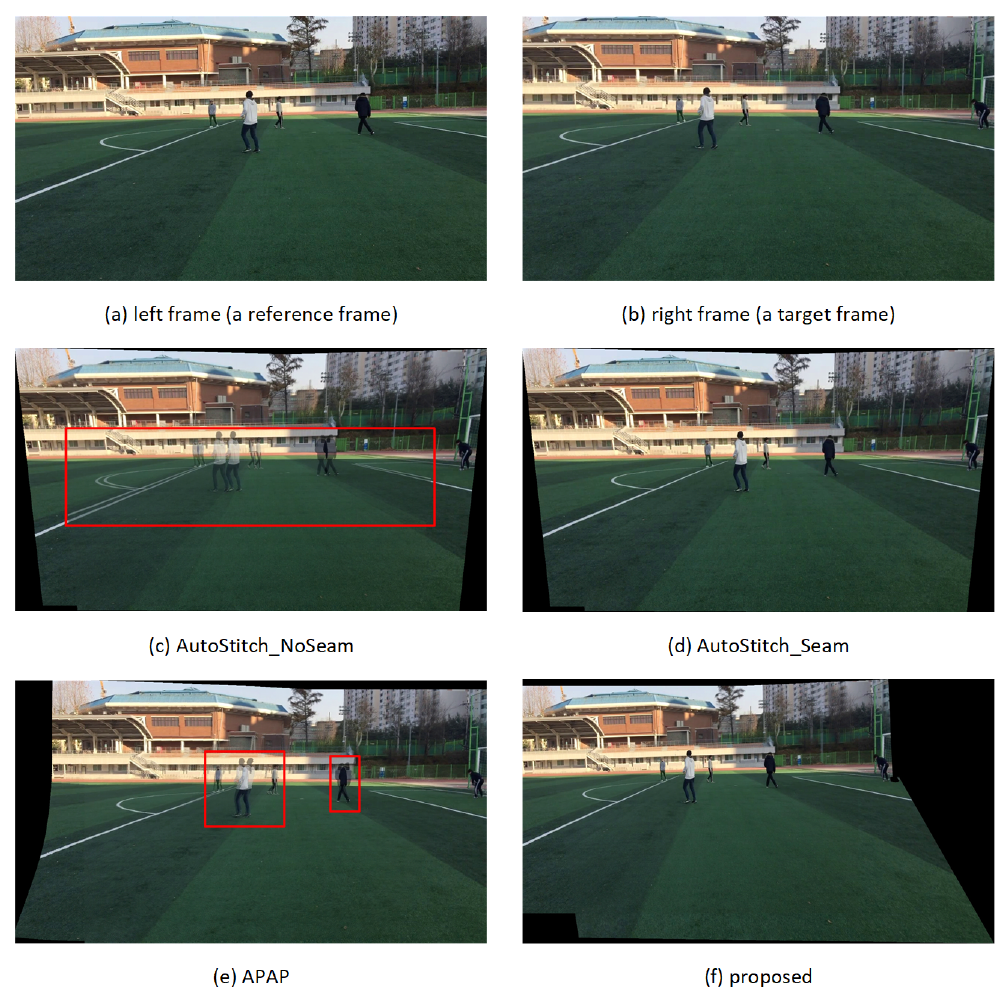
Figure 8. Quality comparison of stitched video frames: seq1